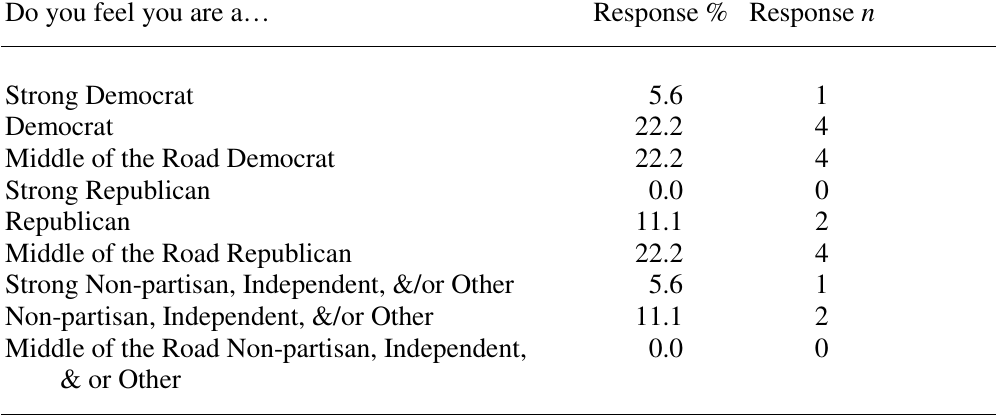
Political Feelings Do you feel you are a… Response % Response n Strong Democrat 5.6 1 Democrat 22.2 4